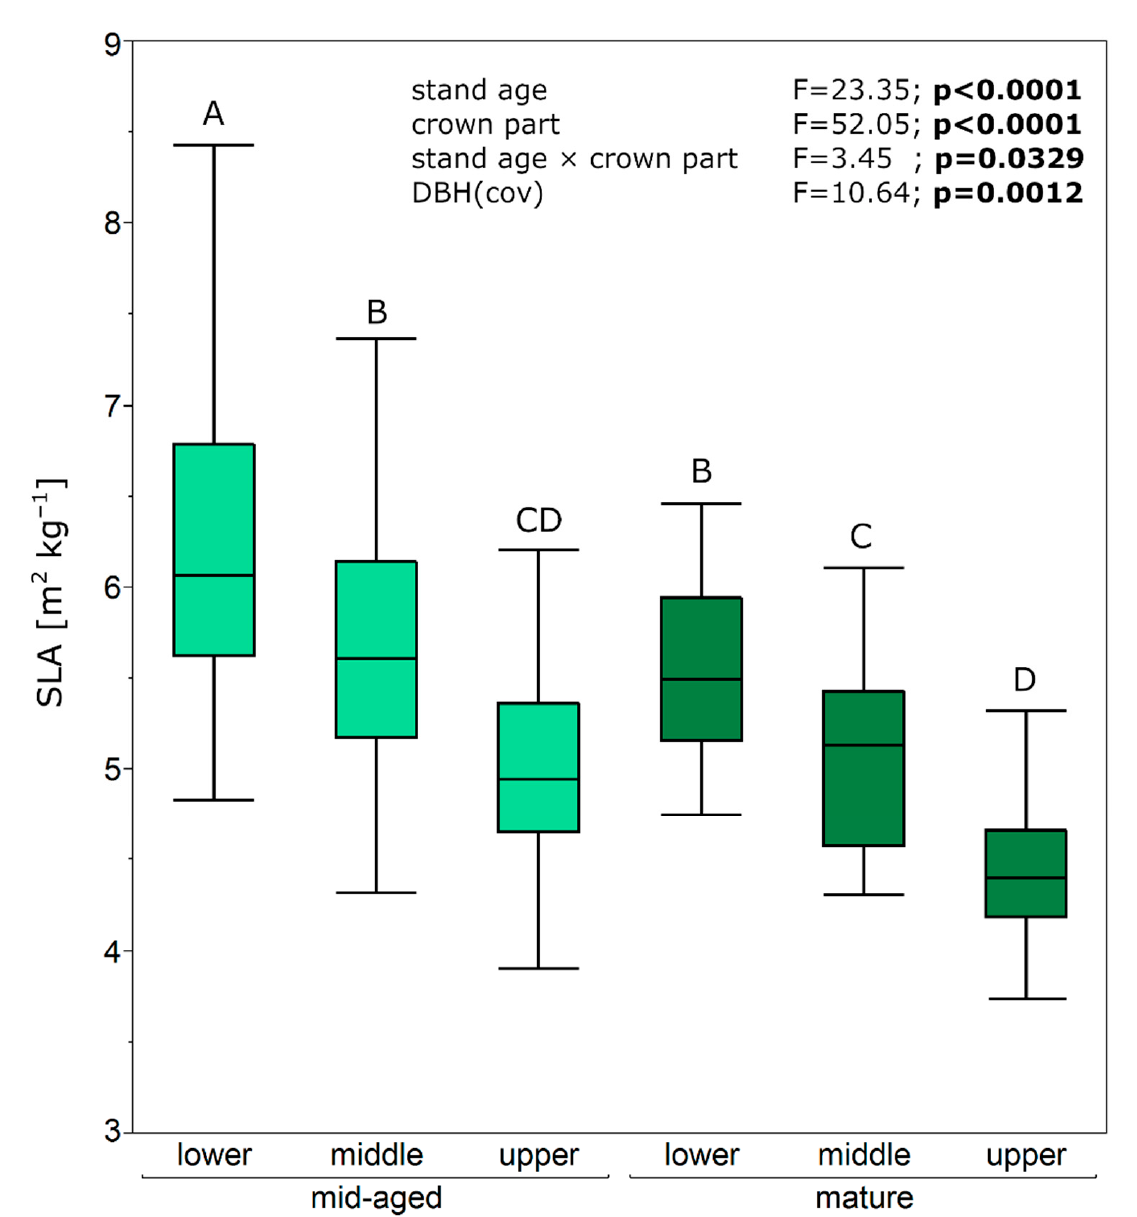
Figure 2. Boxplots with specific leaf area (SLA) of needle different crown parts (lower, middle, and upper) of Scots pine sample trees growing in mid-aged and mature stands. Results of the ANCOVA are presented. Different letters indicate significant differences (Tukey’s honestly significant difference test) between stands of different ages and crown parts ( p = 0.05). Statistically significant differences at p < 0.05 are shown in bold. The mean SLA of the whole tree crown differed significantly between stands of different densities for mid-aged stands ( p < 0.0001) and mature stands ( p = 0.0003). It also differed for each part of the crown except the lower part of the crown in mature stands (Table